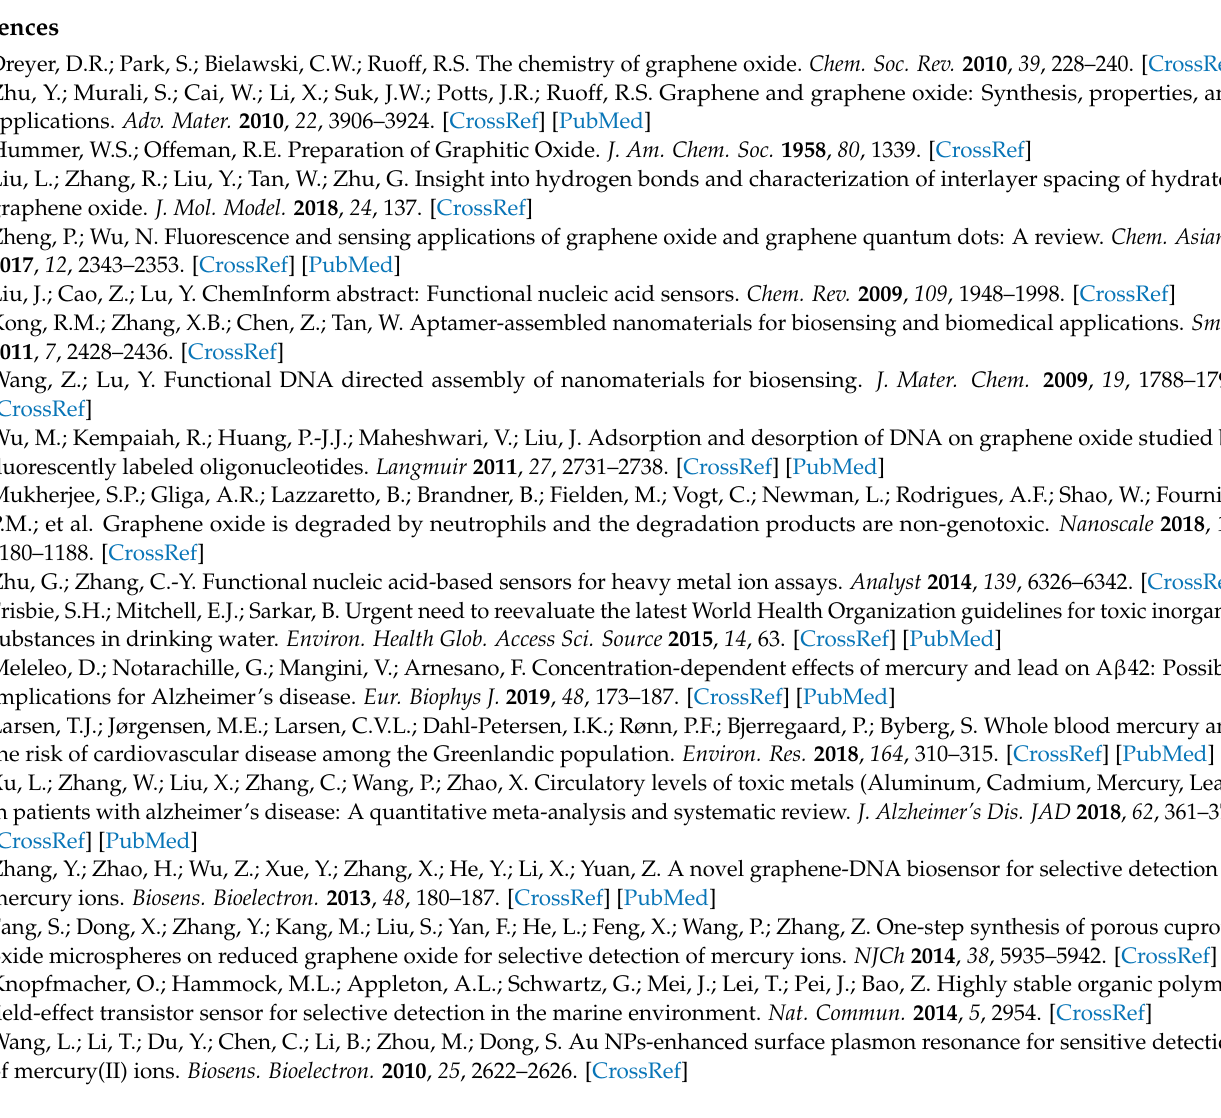
Figure S4 Optimization of activated GO concentration based on sensors containing DNA sequences II hybrid with two PS cutting sites. Figure S5 Sensitivity analysis for Hg 2+ detection based on sensors containing DNA sequences II hybrid with two PS cutting